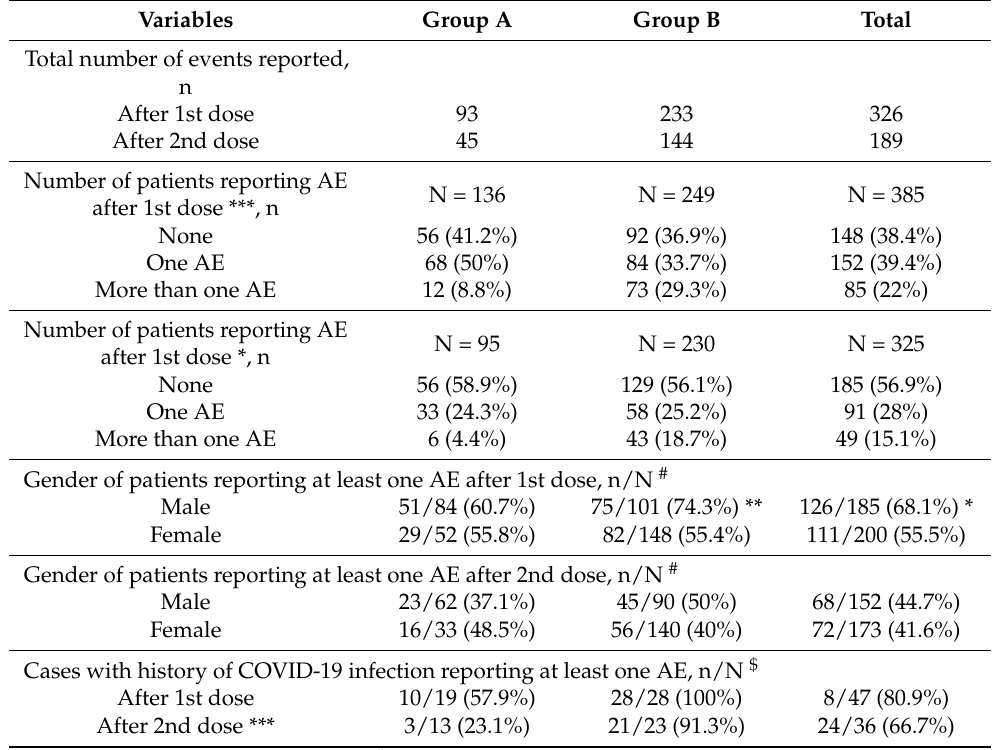
Table 2. Characteristics of children reporting AE after first and second dose of Pfizer-BioNTech’s m-RNA COVID-19 vaccine in group A (5–11 years) and group B (12–17 years).